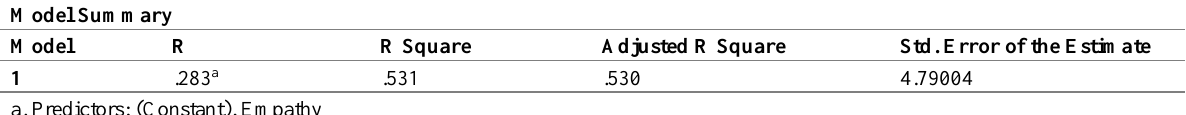
Table 14: Regression Analysis of The Relationship between Empathy and Customer Satisfaction